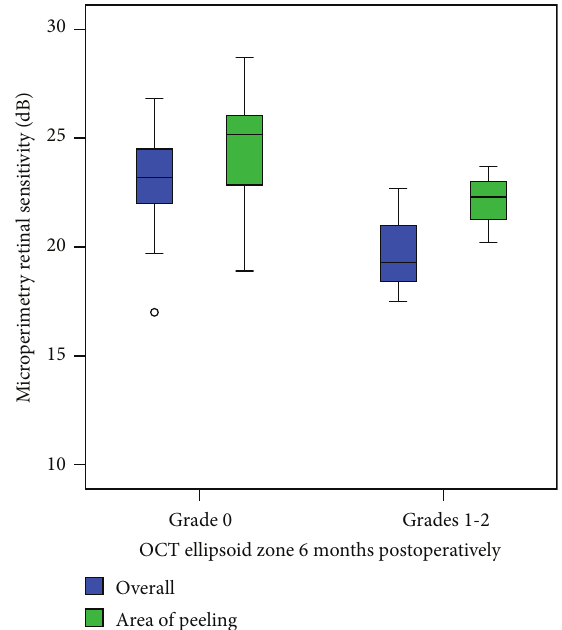
Figure 6: Mean retinal sensitivity based on EZ grading in OCT measurements 6 months postoperatively. A significant difference between intact EZ zone (grade 0) and retinal sensitivity compared to disrupted (grades 1-2) EZ zone in both OCT measurements overall and in areas of peeling could be demonstrated ( 𝑝 < 0.05